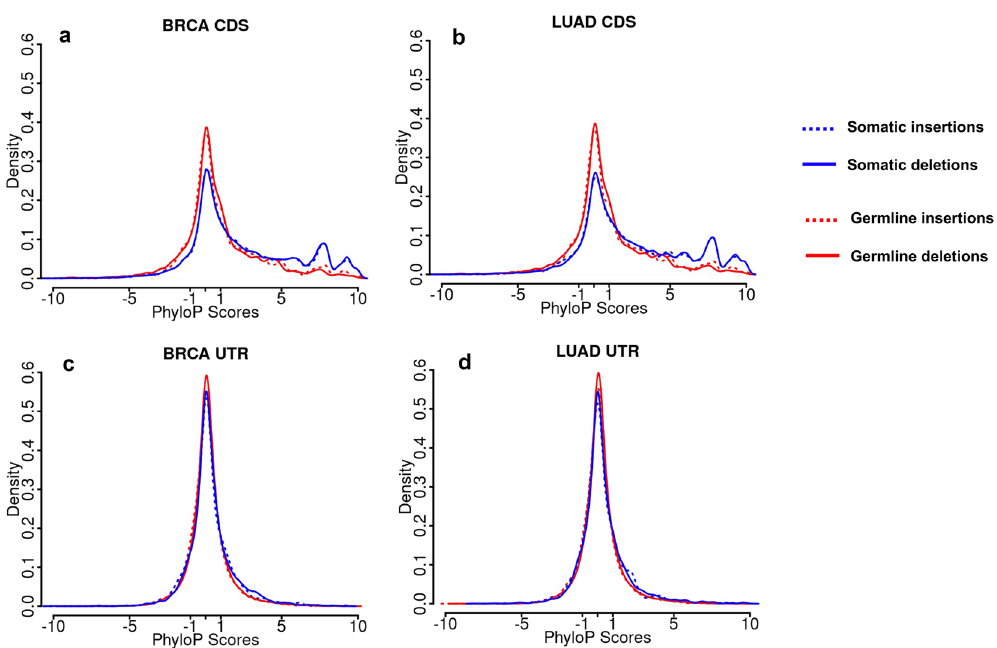
Figure 2. Distributions of the phyloP scores in somatic and germline CDS and UTR indels. ( a ) BRCA CDS indels; ( b ) LUAD CDS indels; ( c ) BRCA UTR indels; and ( d ) LUAD UTR indels. Blue is for somatic indels and red is for germline indels. The dashed line represents insertions and the solid line represents